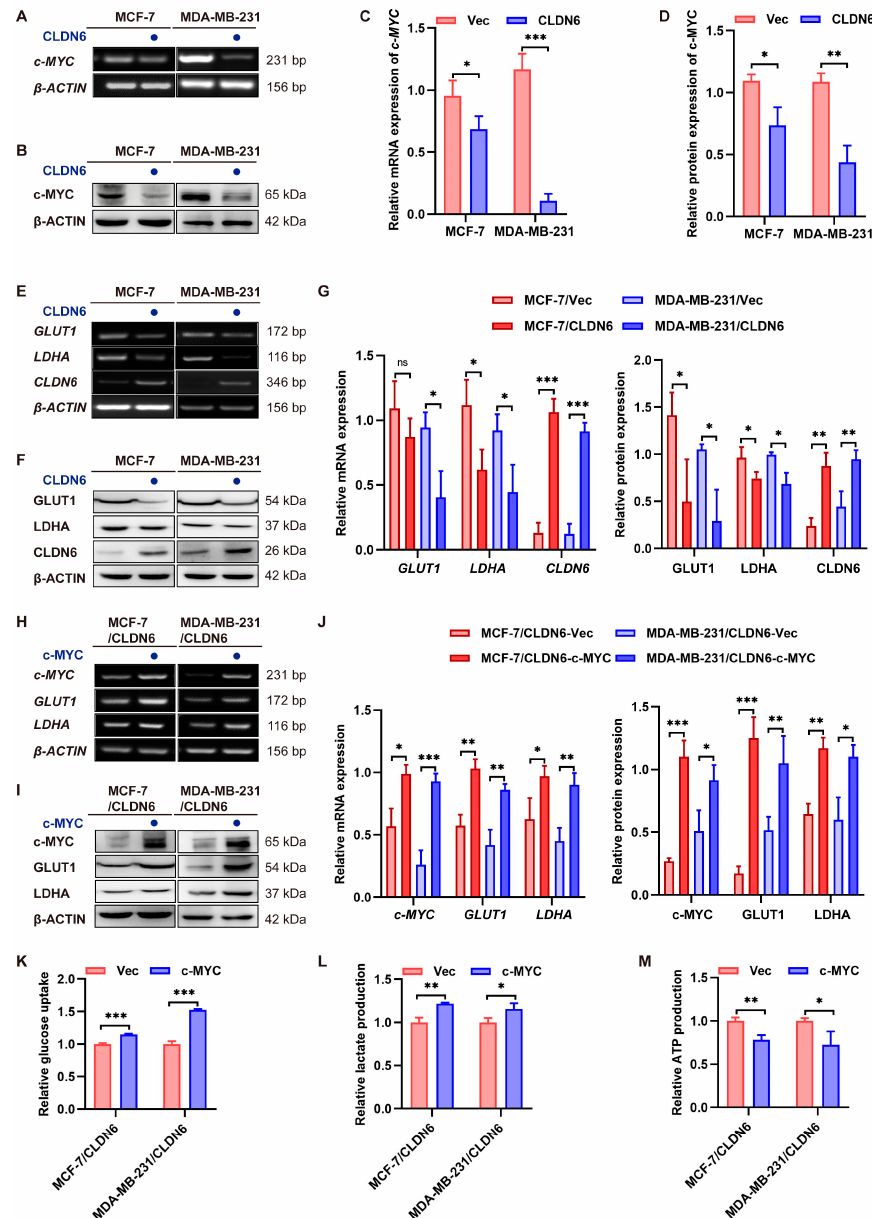
Figure 5. CLDN6 inhibits aerobic glycolysis by down-regulating c–MYC and its target genes GLUT1 and LDHA. RT-PCR ( A , B ) and WB ( C , D ) analysis of the impact of CLDN6 on c–MYC in MCF–7 and MDA–MB–231 cells. ( E – G ) RT–PCR and WB analysis of the effect of CLDN6 on GLUT1 and LDHA in MCF–7 and MDA–MB–231 cells. ( H – J ) RT–PCR and WB analysis of the effect of c–MYC on GLUT1 and LDHA in MCF–7/CLDN6 and MDA–MB–231/CLDN6 cells. Glucose uptake assays ( K ), lactate production assays ( L ), and ATP production assays ( M ) with MCF–7/CLDN6 and MDA–MB– 231/CLDN6 cells expressing vector or c–MYC. ns, no significance, * p < 0.05, ** p < 0.01, *** p < 0.001.